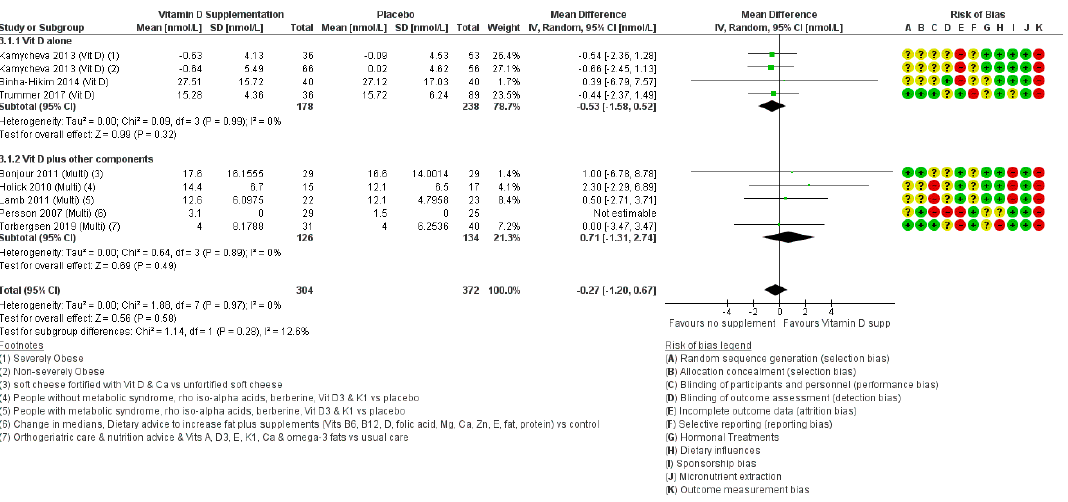
Figure 3. Forest plot assessing effects of increasing vitamin D intake and vitamin D amongst other nutrients, on IGF-1 (nmol/L). Multi, multi-nutrient; vit D, vitamin D. Please refer to Supplementary Table S5, E to find detailed information on the studies and reference details.